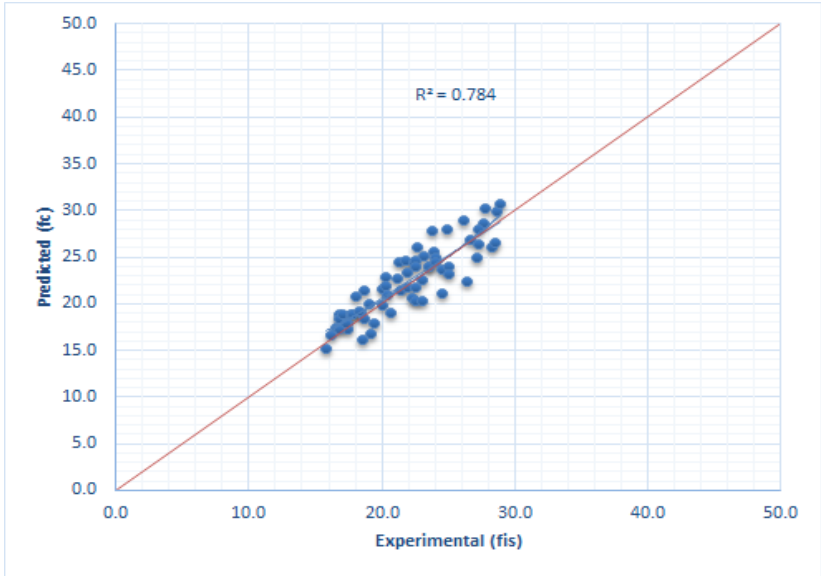
Figure 8. Correlation between experimental and calculated compressive strength.